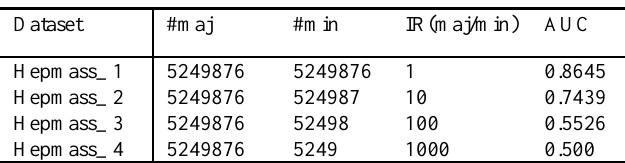
TABLE III D ETAILS OF S YNTHETIC HEPMASS D